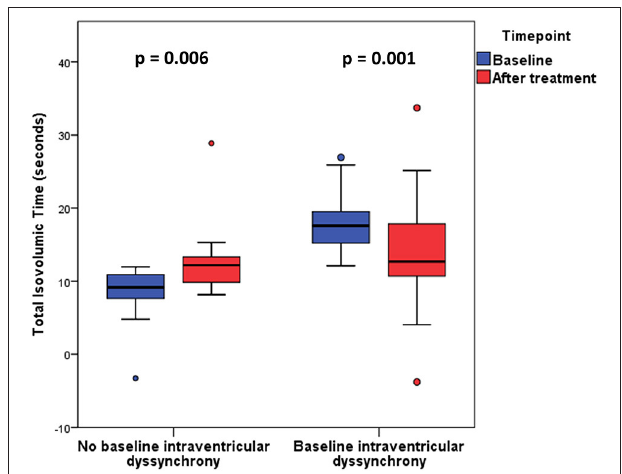
FIGURE 2 | Total Isovolumic time before and after treatment in patients with and without baseline intraventricular dyssynchrony.